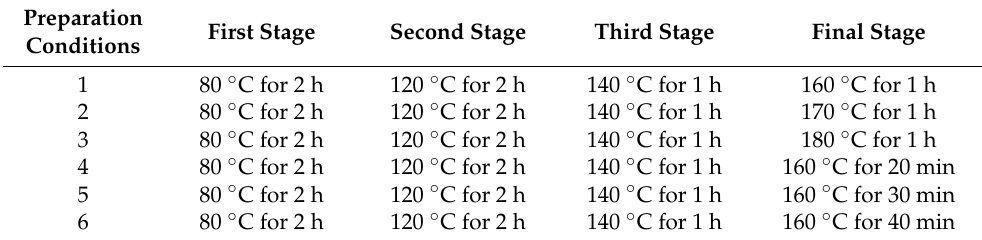
Table 2. Preparation Conditions of CFRP/EPDM